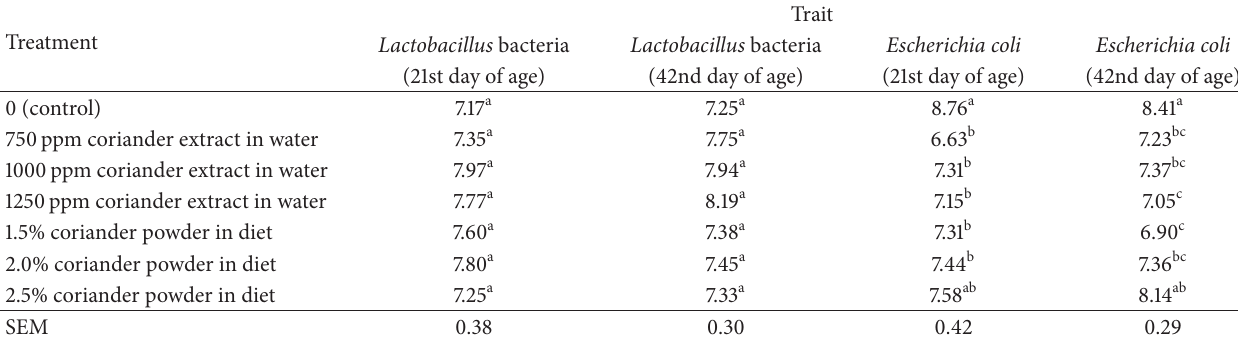
Table 8: Ileum microflora mean ( ± SEM) of Ross 308 broilers at starter, grower, and total periods of age fed diets or water containing the different levels of coriander ( Coriandrum sativum L.) powder and extract from 1 to 6 weeks of age (CFU/g) a,b,c .